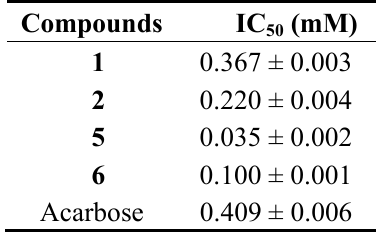
Table 4. α -Glucosidase inhibitory activity of compounds 1 , 2 , 5 and 6